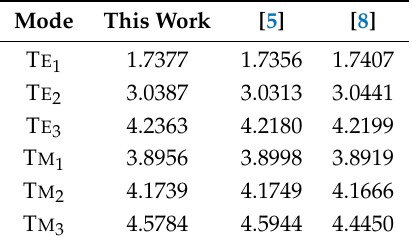
Figure 2. Symmetric waveguides considered in the present work: ( Top ) coaxial waveguide (r = 1 cm, a = 0.5 cm, b = 0.25 cm, [5]), ( Middle ) rectangular waveguide with rounded corners (a = 0.1 cm, b = 0.2 cm, [25]), ( Bottom ); double-ridged waveguide (a = 1.27 cm, b = 1.016 cm, c = 0.508 cm, d = 0.3683 cm, [26]). Table 3. Cutoff wavenumbers κ c [rad · cm − 1 ] for the coaxial waveguide.